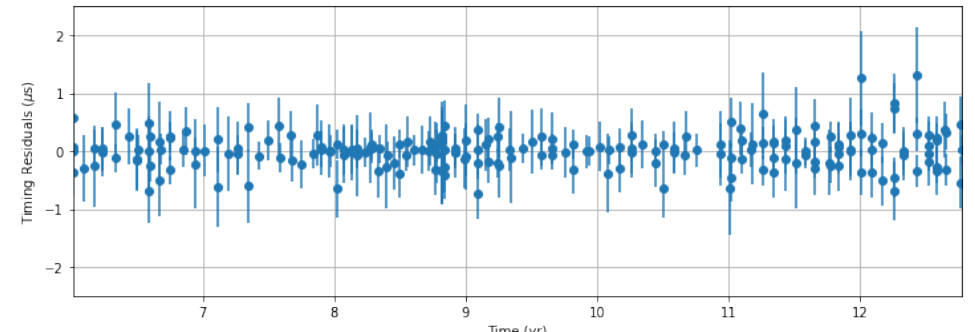
Figure 10. Plot of the averaged narrowband post-fit whitened TRs of the MSP J2145–0750, filtered by removing the TRs associated with an uncertainty larger than 3 σ w and the TRs before the sixth year of observation. The horizontal axis indicates the time, expressed in years. The vertical axis indicates the averaged narrowband post-fit whitened TRs, expressed in nanoseconds.